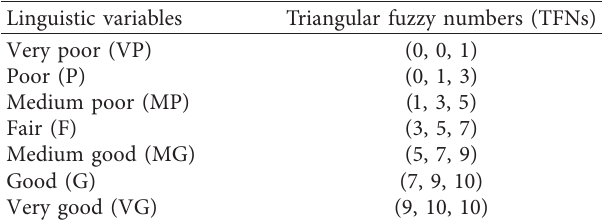
Table 3: Linguistic variables and TFNs for the evaluation of